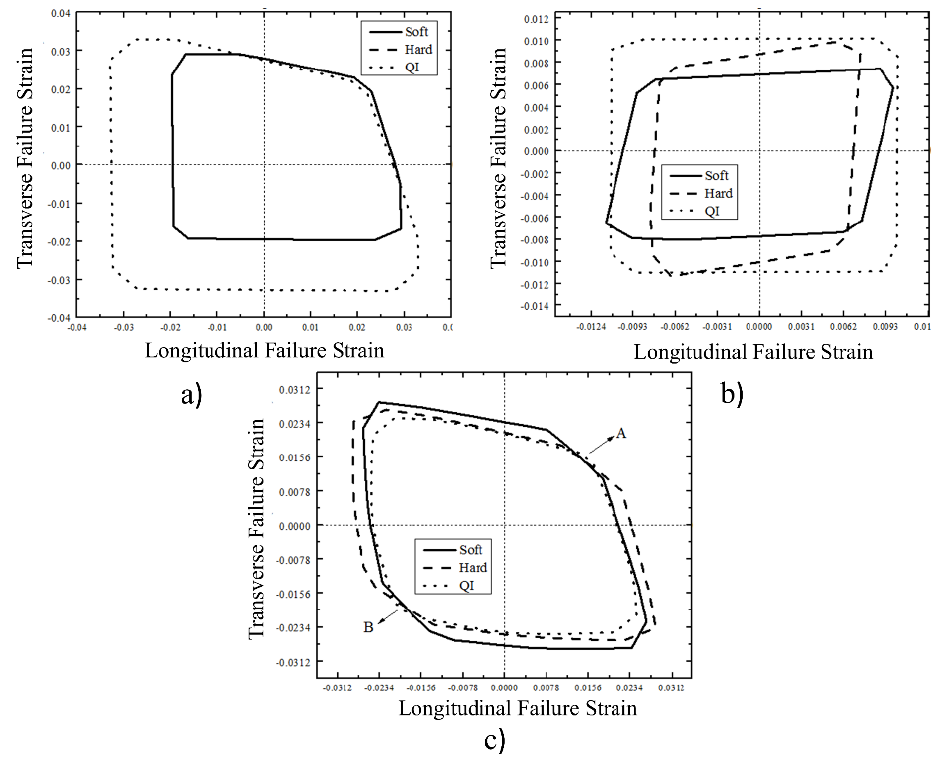
Figure 5 . Comparison of failure envelops for different laminate sequences ( a ) Un-notched laminate ( b ) Open-hole laminate ( c ) Filled-hole laminate .